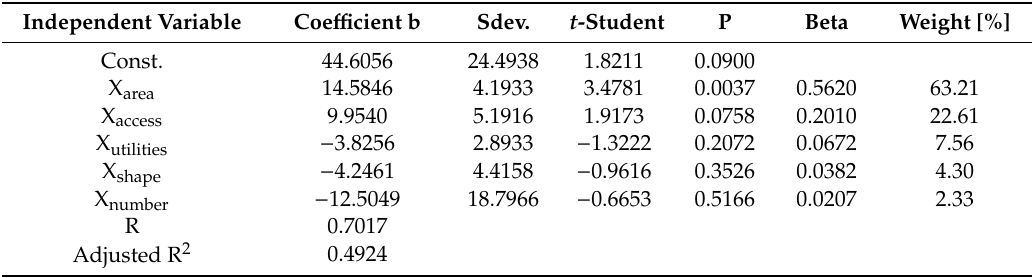
Table 3. Modeling results for determining the weight of individual attributes for the “ex ante” plot condition.